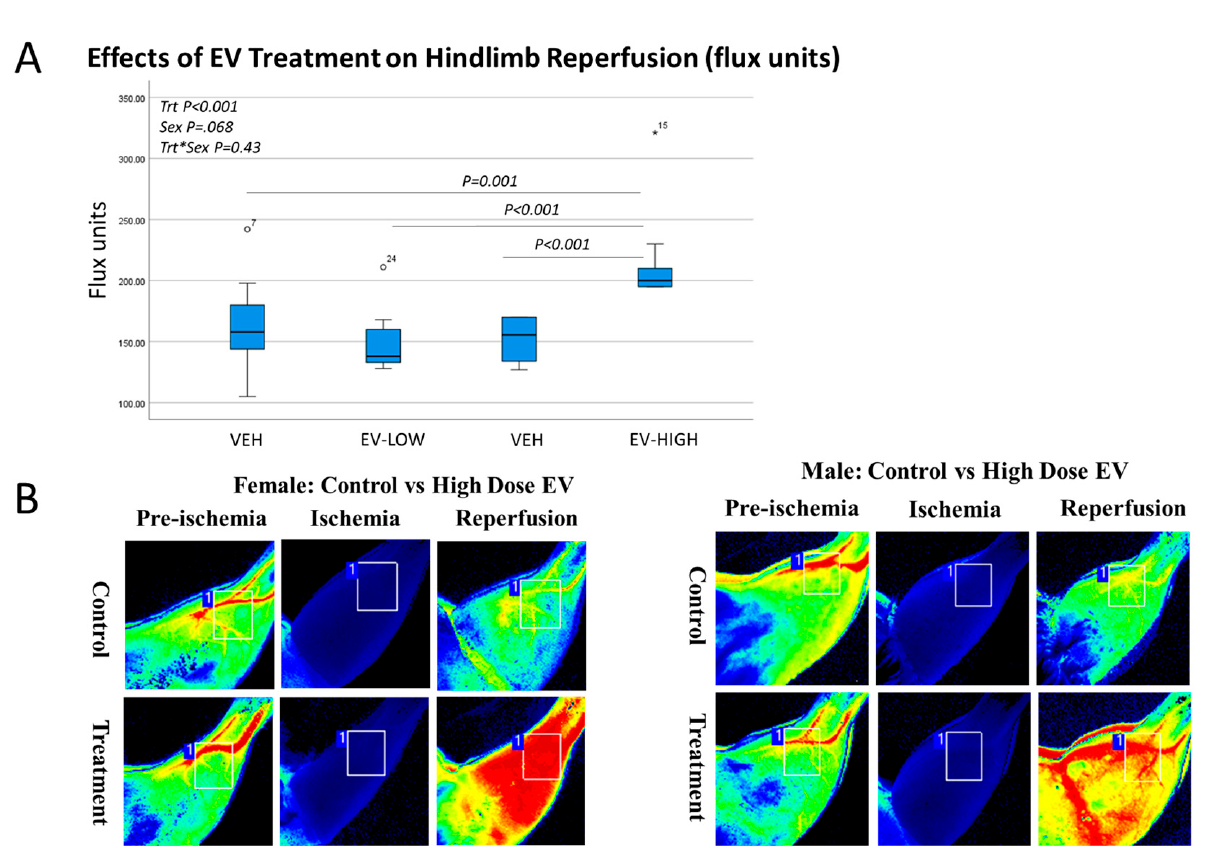
Figure 3. Effects of EV treatment on hindlimb reperfusion. ( A ). Box-and-whisker plots showing a significant increase in reperfusion with the high-dose EV treatment. Two-factor ANOVA was performed with treatment and sex as the two factors ( n = 5 male, 5 female per group). ( B ). Laser Doppler images of hindlimbs from male and female mice receiving vehicle (control) or high dose (100 µg) EVs showing increased perfusion in the treated mice. °,* represent outliers in ( A ).